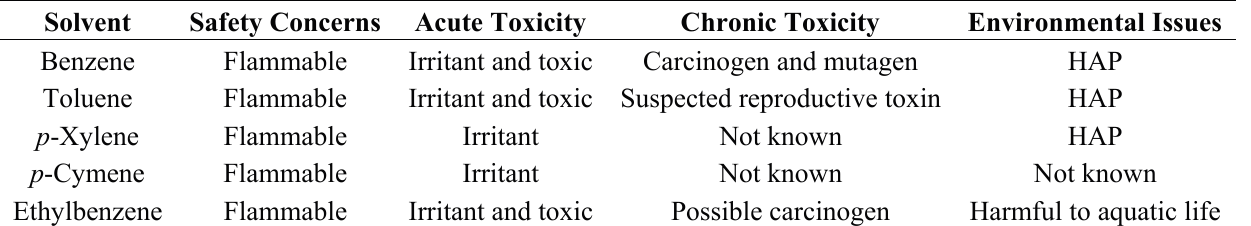
Table 3. Issues surrounding aromatic solvents, as gauged from safety data sheets (some hazards may be